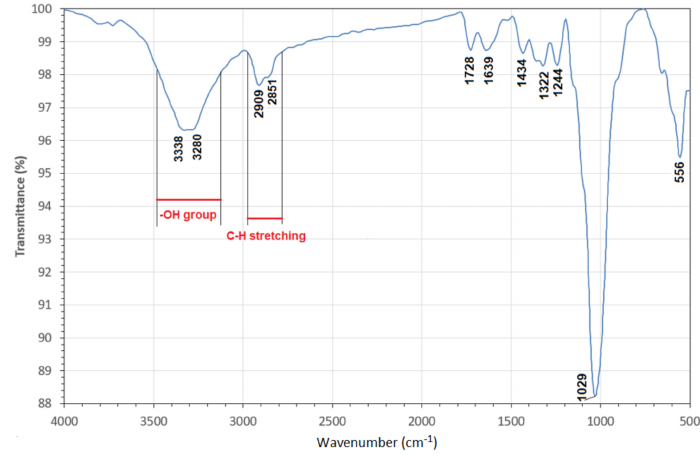
Figure 4. FTIR spectrum for PCLF.